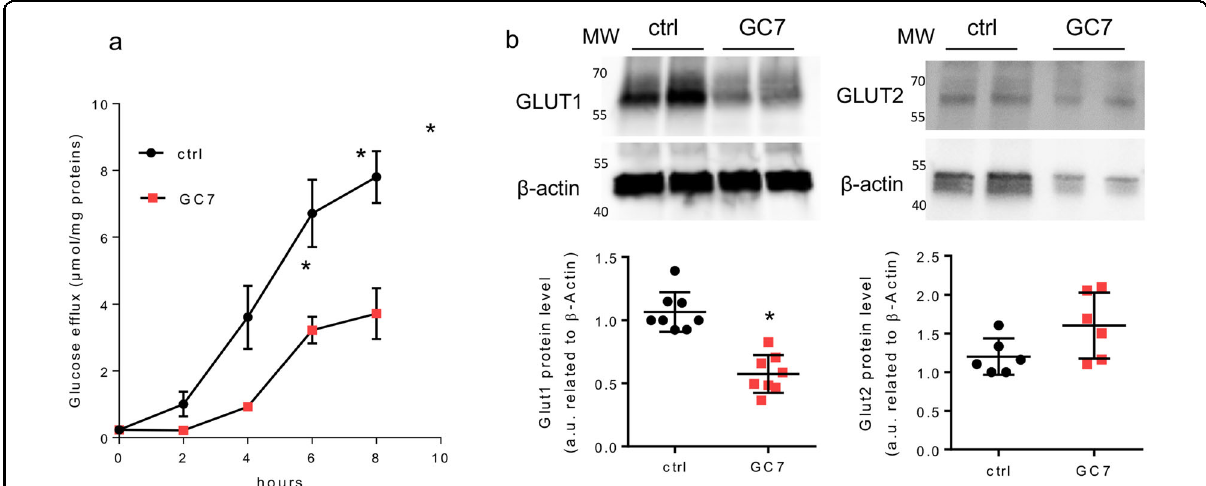
Fig. 5 GC7 modulates glucose fl ux in PCT cells. Con fl uent PCT cells were treated or not with 30 µM GC7 for 24 h and then used for different analysis. a At the end of treatment cells were deprived in glucose and the ef fl ux of glucose was measured in the next 8 h. Dots displayed mean ± SD of three independent experiments. b Western blot analysis of GLUT1 and GLUT2 expressions in membrane enriched protein lysate from PCT cells. β -Actin was used as loading control. MW molecular weight. * p < 0.05 evaluated using Mann – Whitney